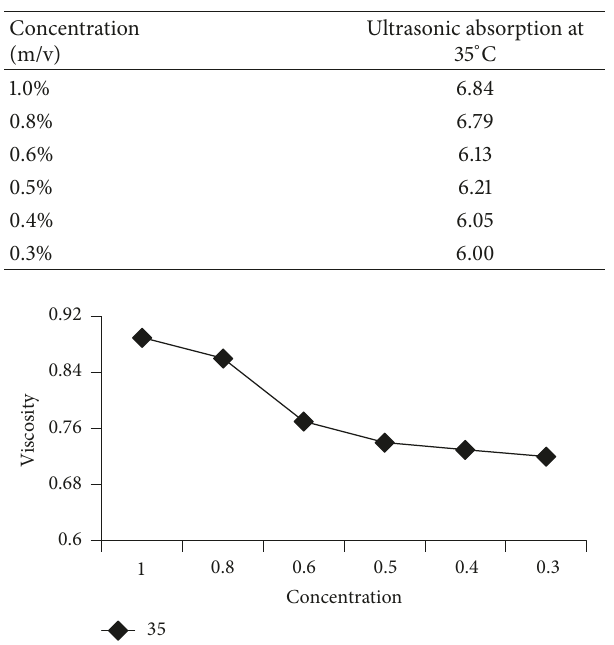
Table 8: Ultrasonic absorption ( × 10 −15 s 2 m −1 ) at different concen- tration at 1 MHz for polyvinyl alcohol (PVA).